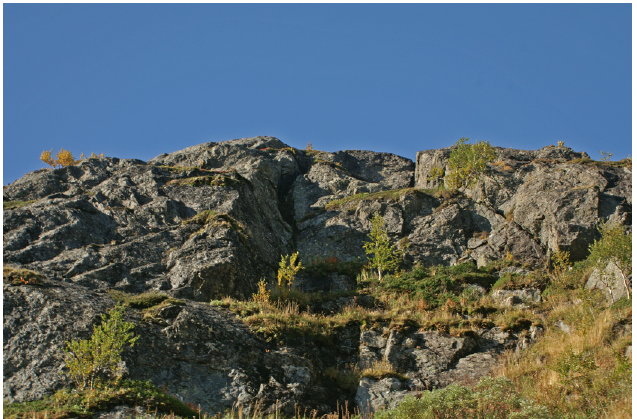
Figure 6: View of the uppermost section of the same type of slope as shown in Figure 5. A particularly complex geo- morphology offers ideal preconditions for substantial tree- line advance (190 m). Mt. Lillstendaslfjället, 1070 m a.s.l. 18 September 2006.